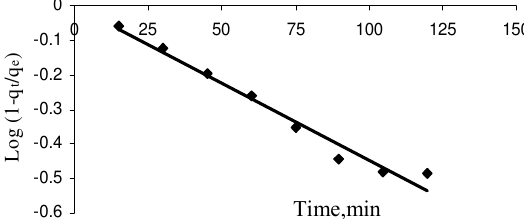
Figure 8. Pseudo-first order model for present system.